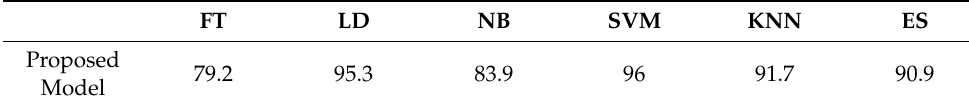
Table 5. Accuracy rate of LBP-mRMR + ResNet50-mRMR